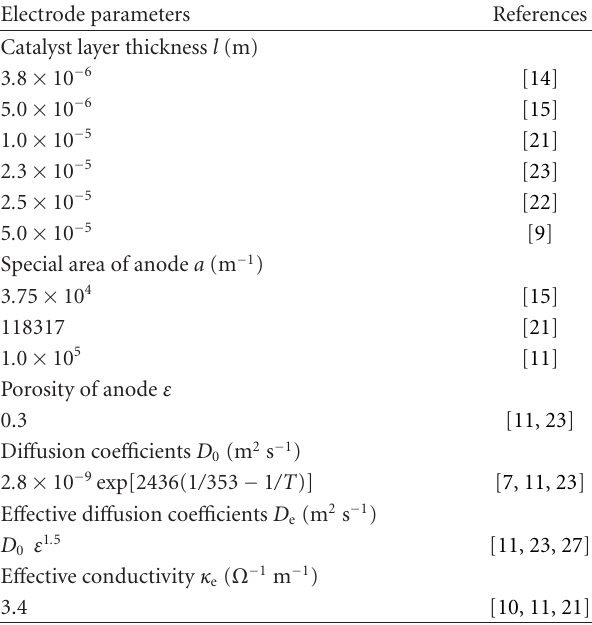
Table 2: Physical parameters for